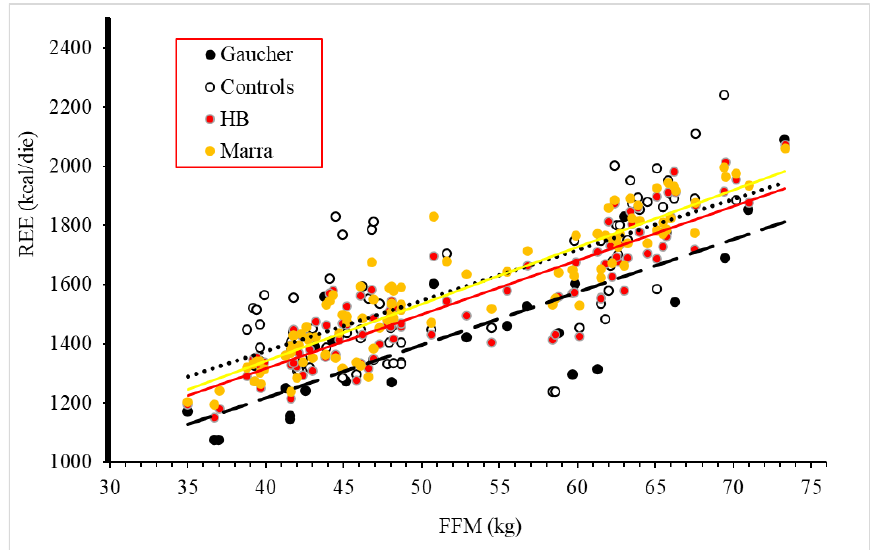
Figure 1. Relationship between fat-free mass (FFM) and resting energy expenditure (REE) in GD1 patients and healthy controls. Gaucher: Gaucher patients. Controls: healthy controls. HB: estimation by Harris-Benedict equation. Marra: estimation by Marra equation.